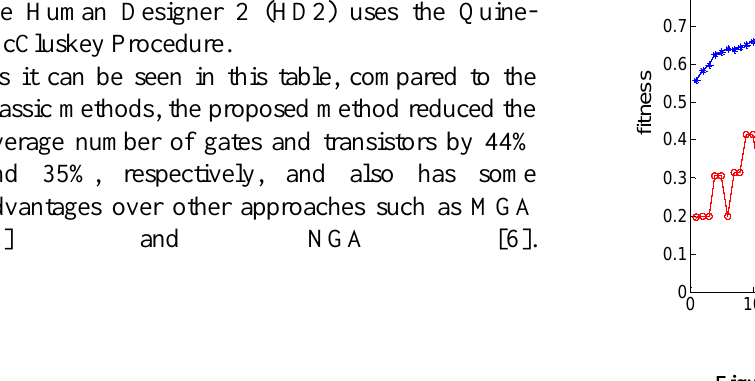
Figure 5. Convergence diagram for F 1. Table 2. Comparison of proposed method vs. similar approaches in terms of general design parameters for function F 1 .